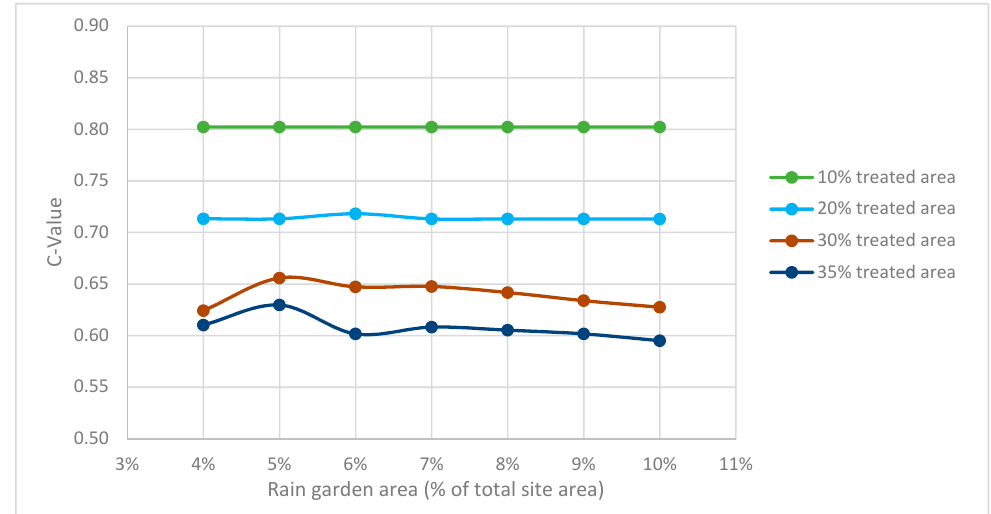
Figure A7. Commercial precinct plot of effective runoff coefficient versus rain garden size for treated catchment areas of 10–35%.